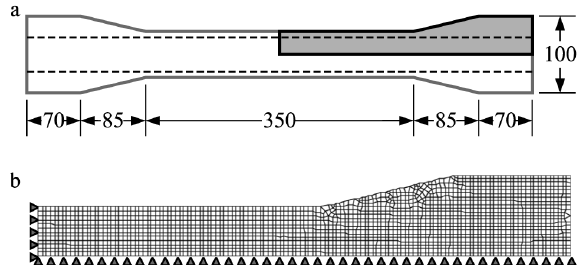
Fig. 4. Geometrical parameters of the test specimen (a) and FE mesh of the model